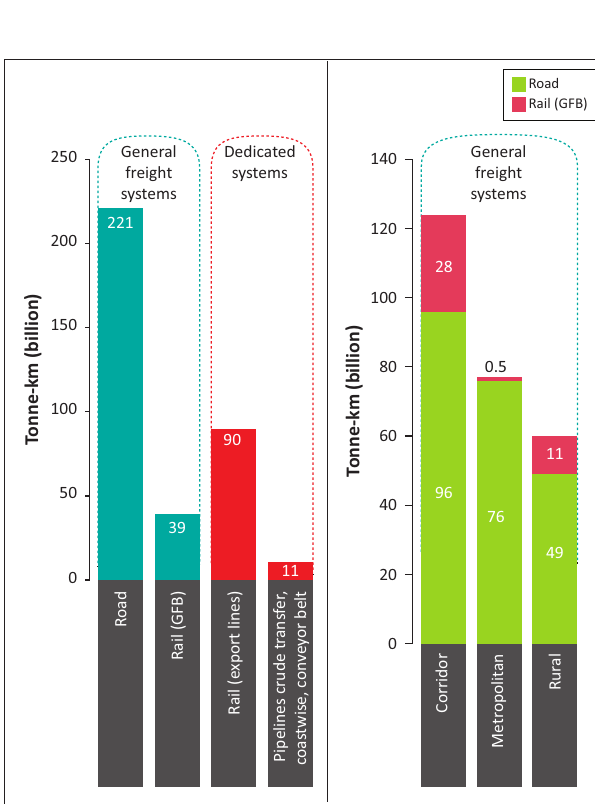
FIGURE 6: Transport cost components.